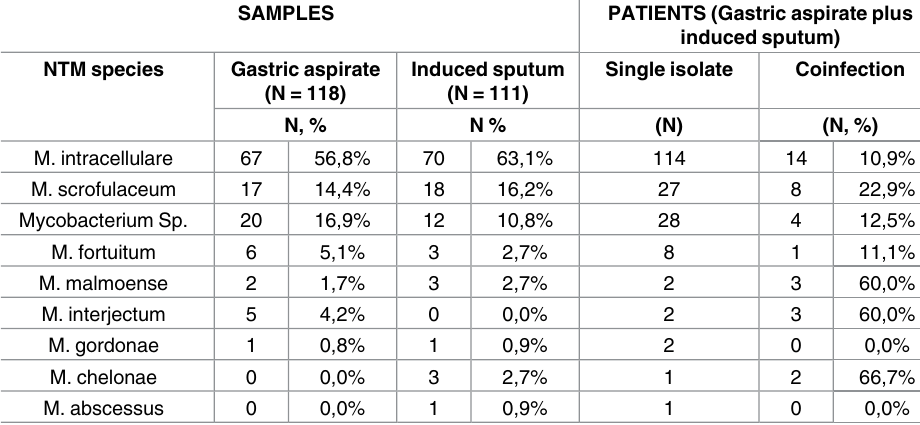
Table 2. Frequency of different specimens according to sample